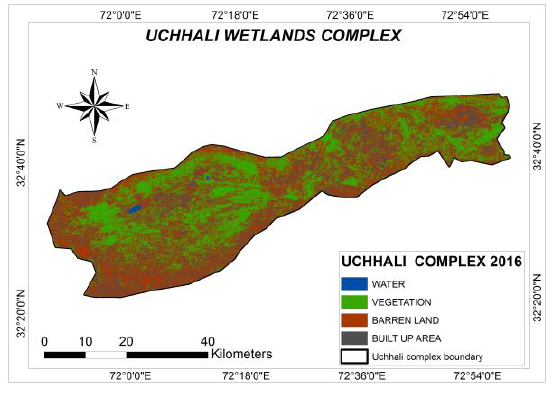
Figure 4. Classified map of Uchhali Complex 2016